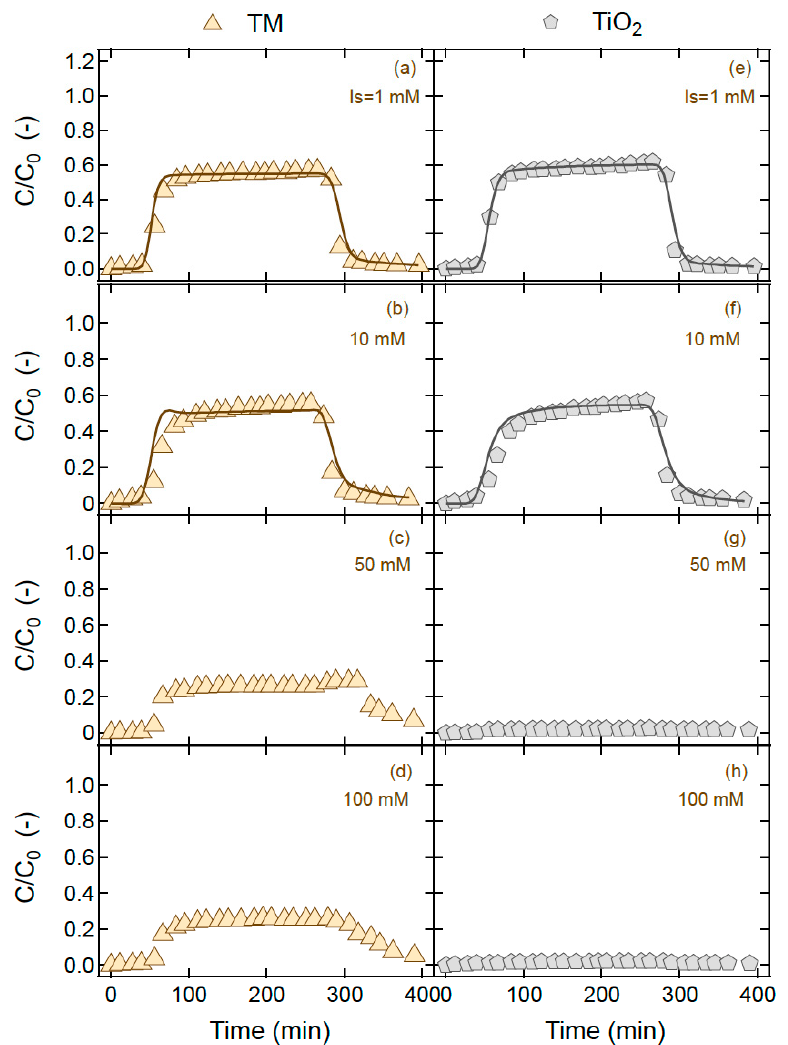
Figure 4. Breakthrough data (symbols) for the cotransport of TM (triangles) ( a – d ) and TiO 2 (pen- tagons) ( e – h ), together with the corresponding fitted curves (solid curves), in a column packed with quartz sand, at 4 different ionic strengths (Is = 1, 10, 50, and 100 mM) as a function of time.